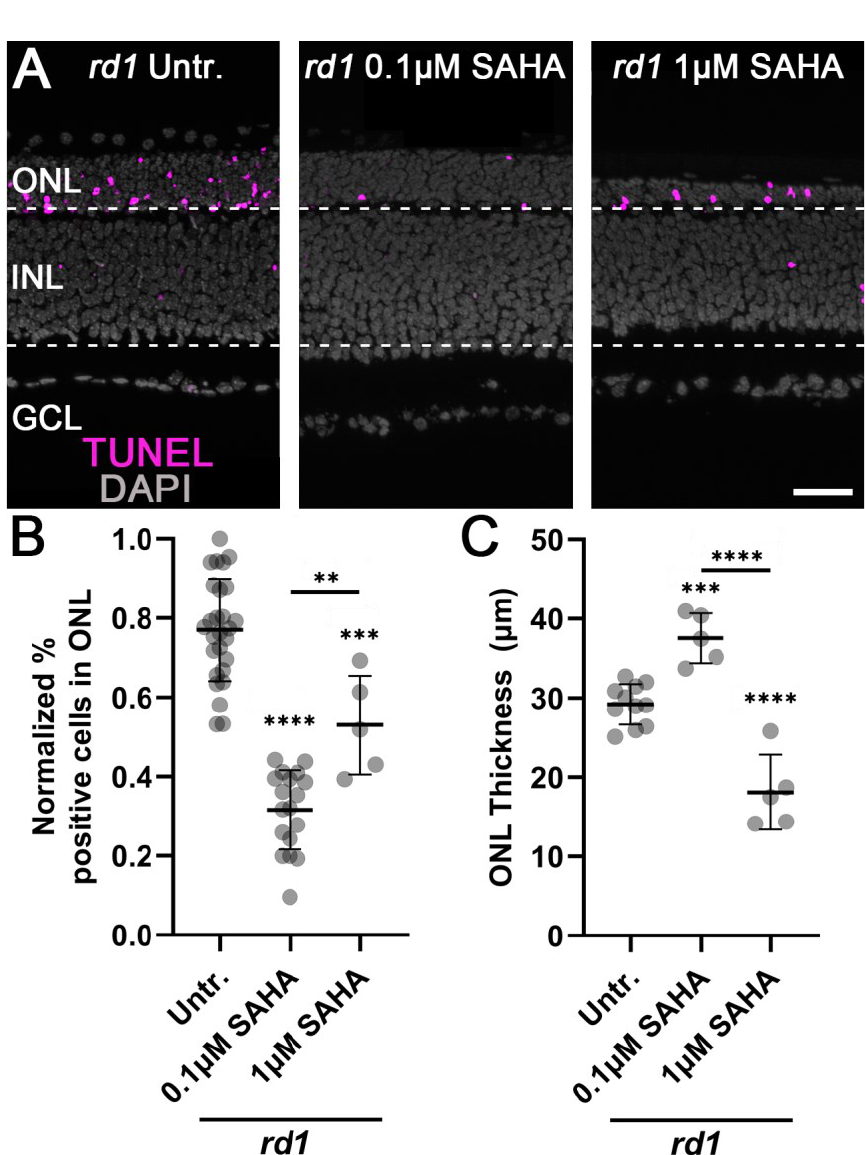
Figure A1. SAHA treatment reduces rd1 photoreceptor cell death. Retinal explants derived from rd1 mice were cultured from post-natal day 5 to 11 and exposed to different SAHA concentrations. ( A ) The TUNEL assay (magenta) was used to label dying cells on retinal cross-sections. DAPI (grey) was used as nuclear counterstain. ( B ) Quantification of cell death in the outer nuclear layer (ONL). While 0.1 μM SAHA strongly reduced the numbers of TUNEL-positive cells in the ONL, 1 μM SAHA was less effective. ( C ) Quantification of photoreceptor rows in the ONL. Treatment with 0.1 μM SAHA produced a small increase in ONL rows, indicating improved rd1 photoreceptor survival. However, 1 μM SAHA clearly reduced the ONL row count. Images shown represent at least five different specimens for each genotype. Untr. rd1 : 27 explants from 27 different mice; 0.1 μM SAHA rd1 : 18/18; 1 μM SAHA rd1 : 5/5; error bars represent SD; INL = inner nuclear layer; GCL = ganglion cell layer. Scale bar = 50 μm; significance levels: **, p < 0.01; ***, p < 0.001; ****, p < 0.0001.